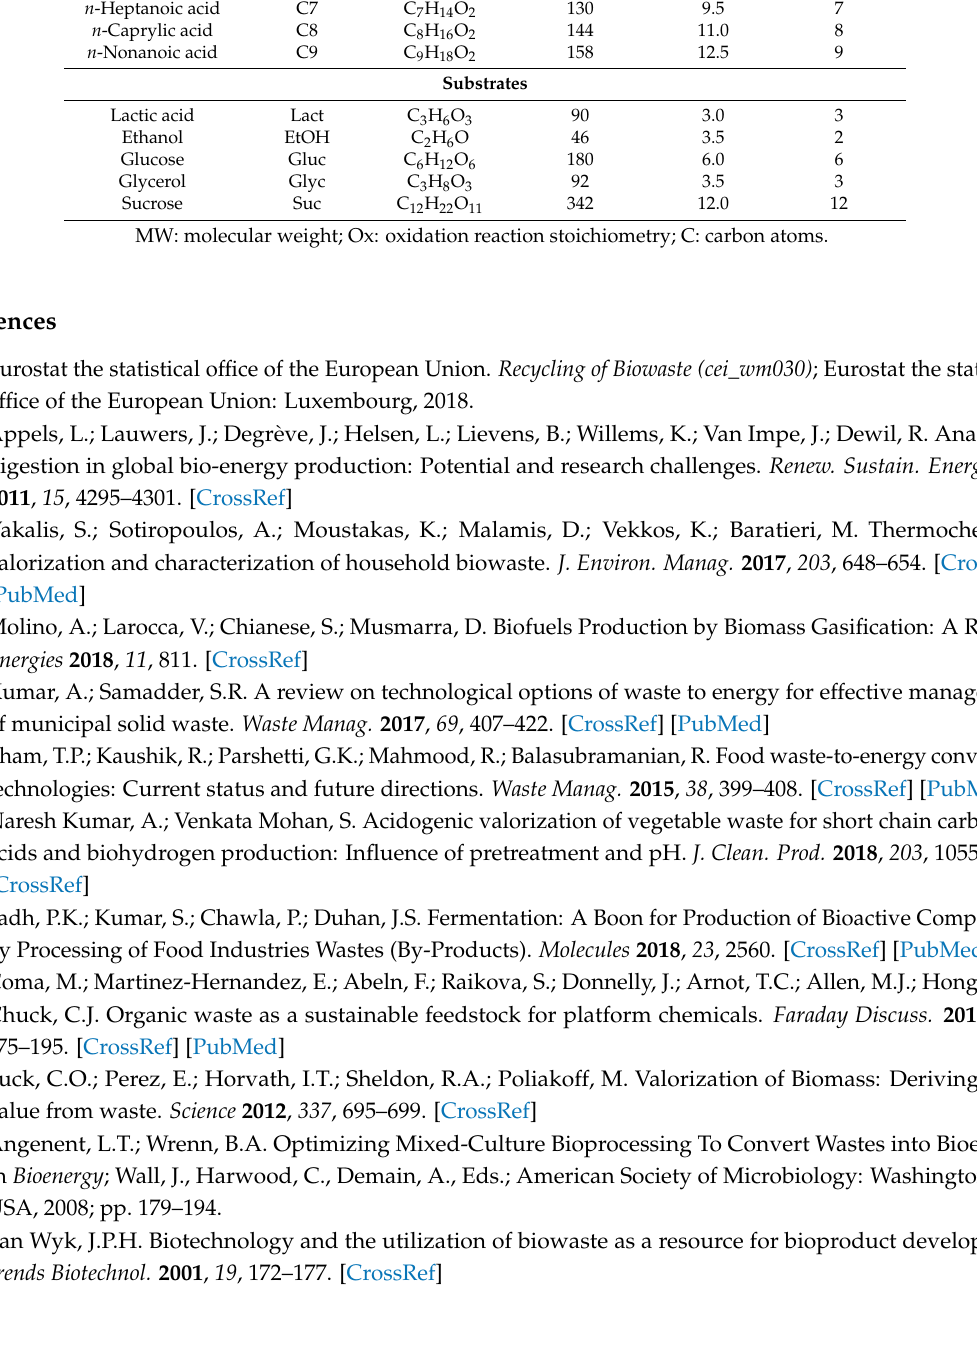
MW: molecular weight; Ox: oxidation reaction stoichiometry; C: carbon